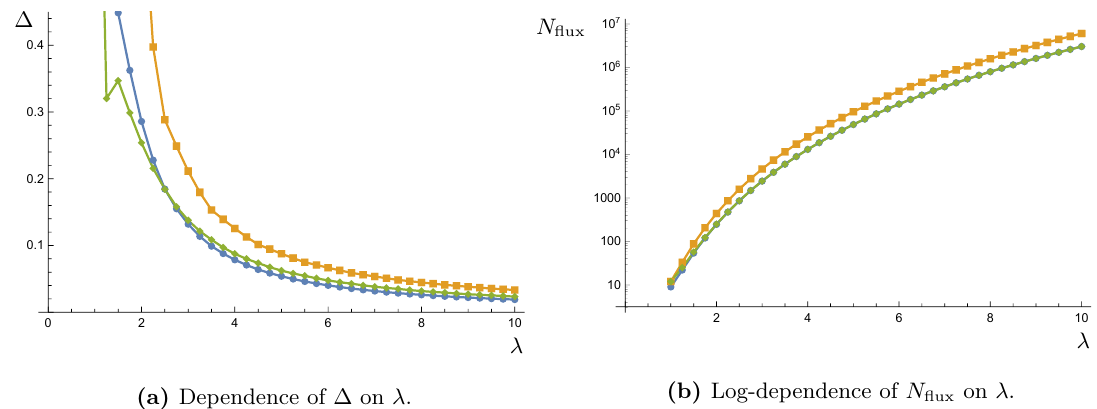
Figure 4. Large complex-structure limit: dependence of the relative difference ∆ and of the tadpole contribution N on the hierarchy parameter λ . The plots show three different families, which all flux show a similar behaviour. Note that in 4b the green and blue line are almost